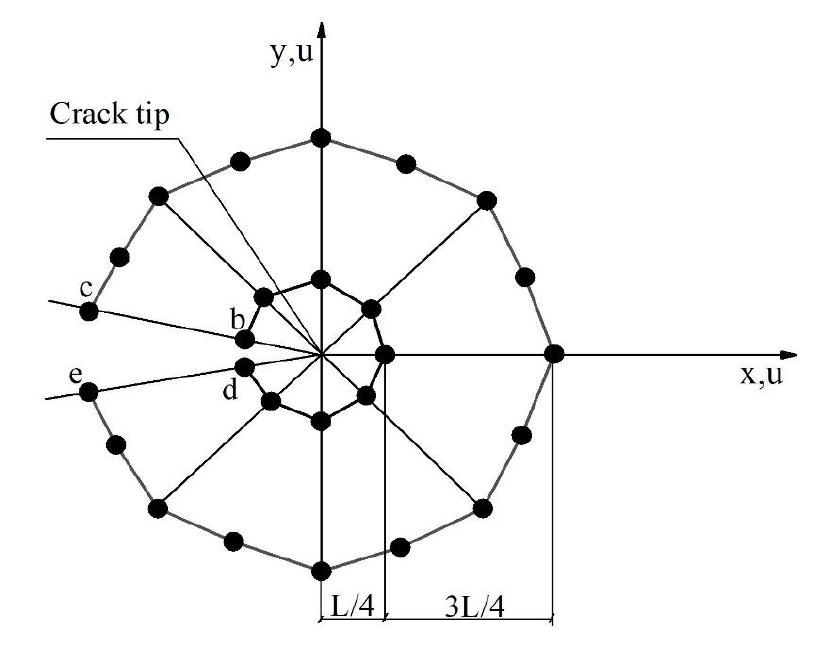
Figure 4. Special elements are used for the displacement extrapolation method.